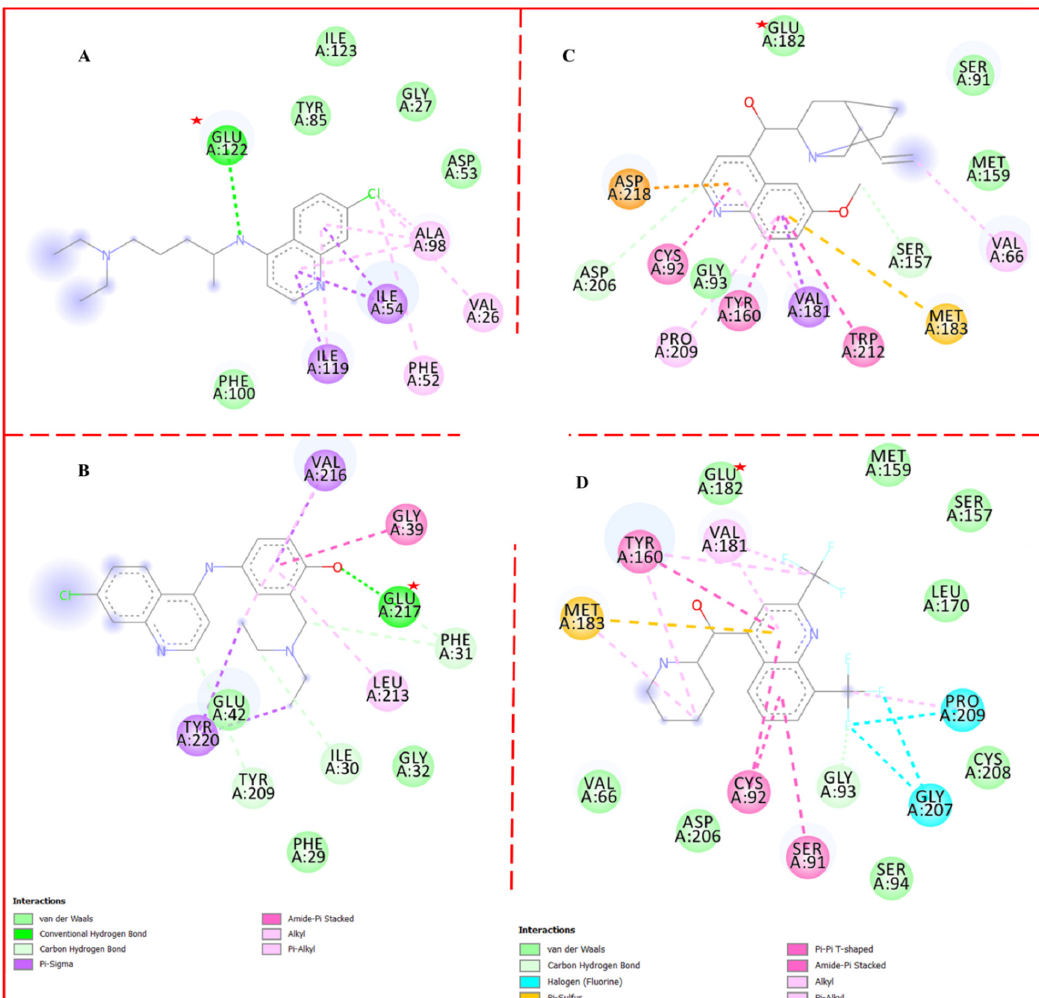
Figure 3. Ligand–receptor interaction profile of mainstay antimalarial drugs highlighting their interaction with Glu. ( A ) Chloroquine in the cofactor binding site of P. falciparum lactate dehydrogenase PDB code: 1CET, ( B ) Amodiaquine in complex with Phosphoethanolamine Methyltransferase from P. falciparum PDB code 4FGZ: ( C ) P. falciparum purine nucleoside phosphorylase in complex with quinine PDB code: 5ZNC and ( D ) P. falciparum purine nucleoside phosphorylase in complex with mefloquine PDB code: 5ZNI. Indicates the position of glutamic acid